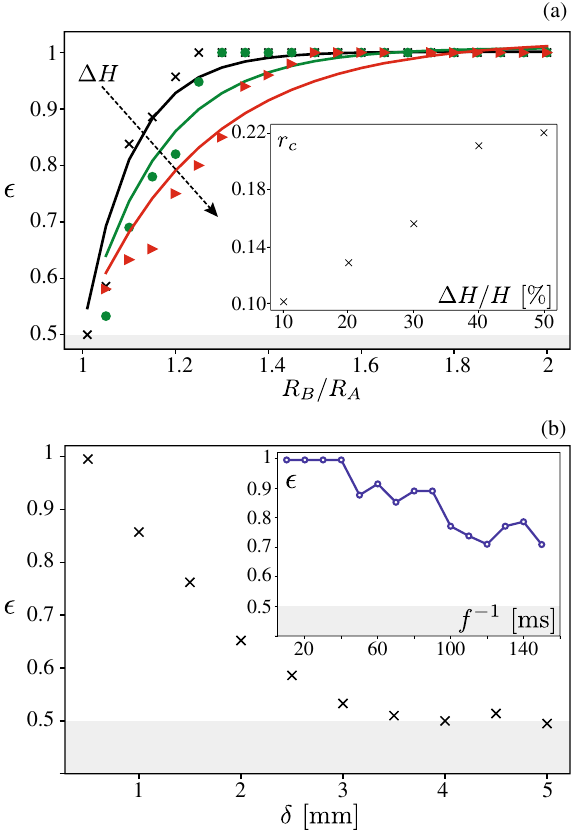
Figure 3. Classification robustness to external noise. ( a ) Classification accuracy obtained for different levels of noise on the initial grain position � H / H = 10% ( × ), 20% ( • ) and 50% ( ◮ ) using grain types of differing radius; lines are the best fits using Eq. (1); (inset) corresponding values of the fitting parameter r c . ( b ) Classification accuracy obtained when adding a noise of magnitude δ on all positions y ( t ), or when decreasing the position sampling frequency f (inset); results correspond to grain types of differing radii, R B = 2 R A and � H / H = 20%. Grey areas correspond to accuracy lower than